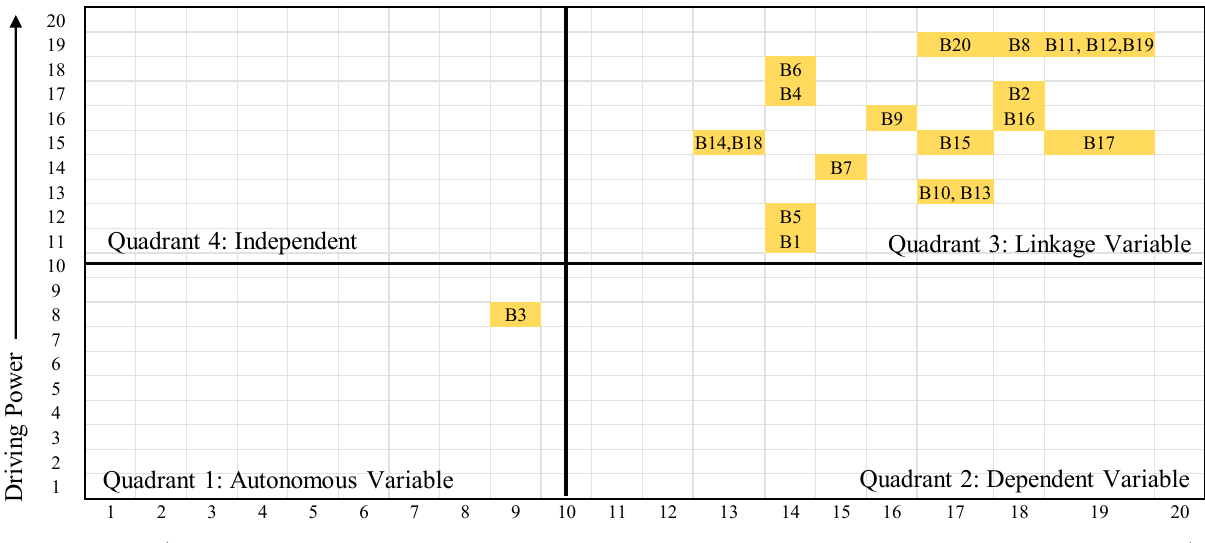
Figure 6. Dependence power vs. driving power by MICMAC analysis.